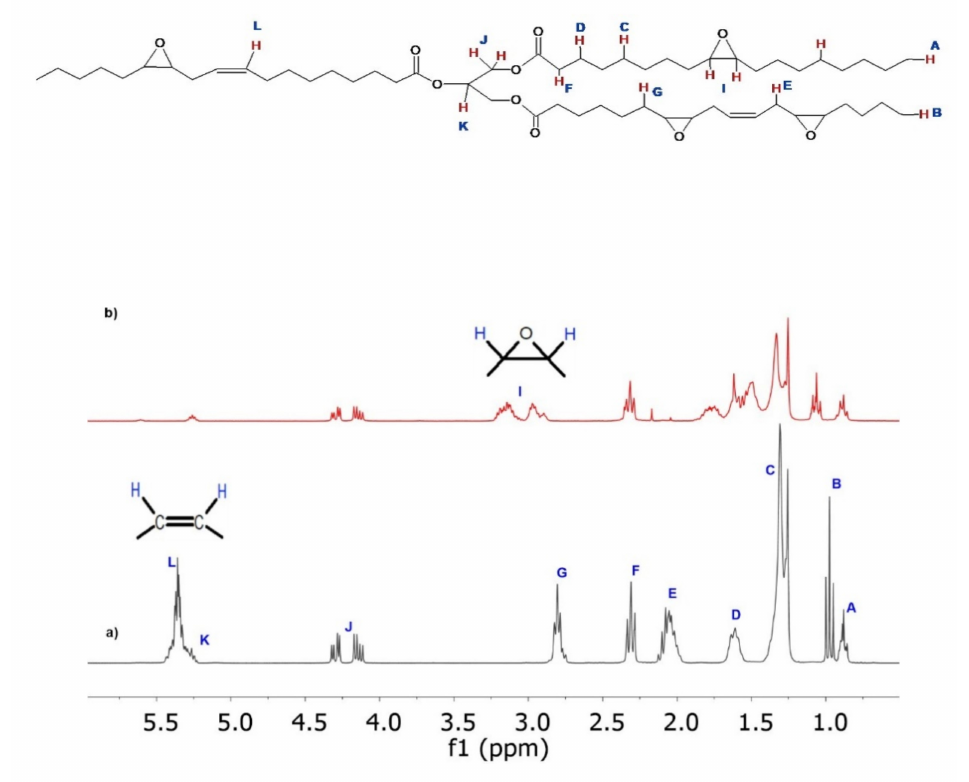
Figure 2. Proton nuclear magnetic resonance ( 1 H-NMR) spectra of ( a ) LO and ( b )